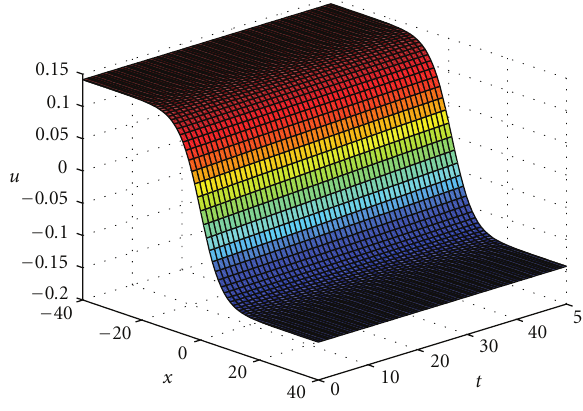
Figure 1: HAM solution with α (cid:8) 1.